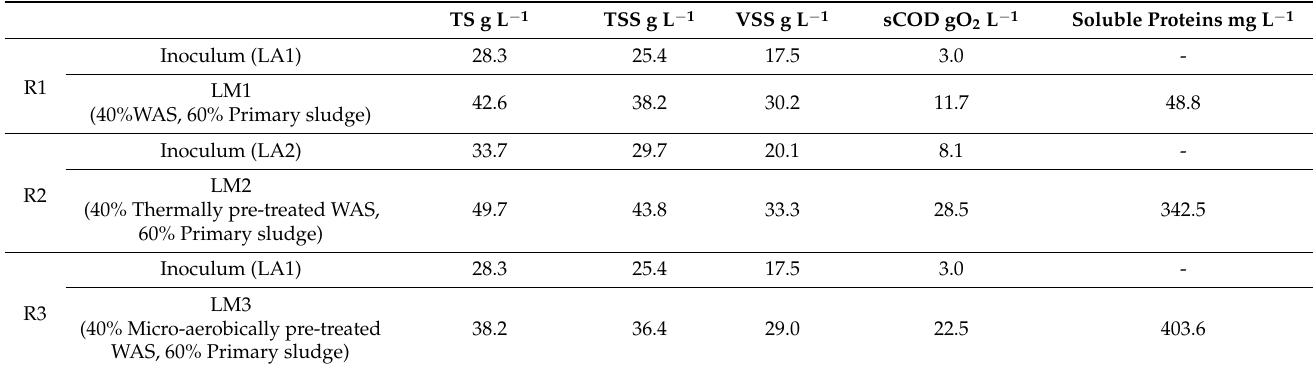
Table 1. Characterization of the substrates and inoculums used in R1, R2 and R3